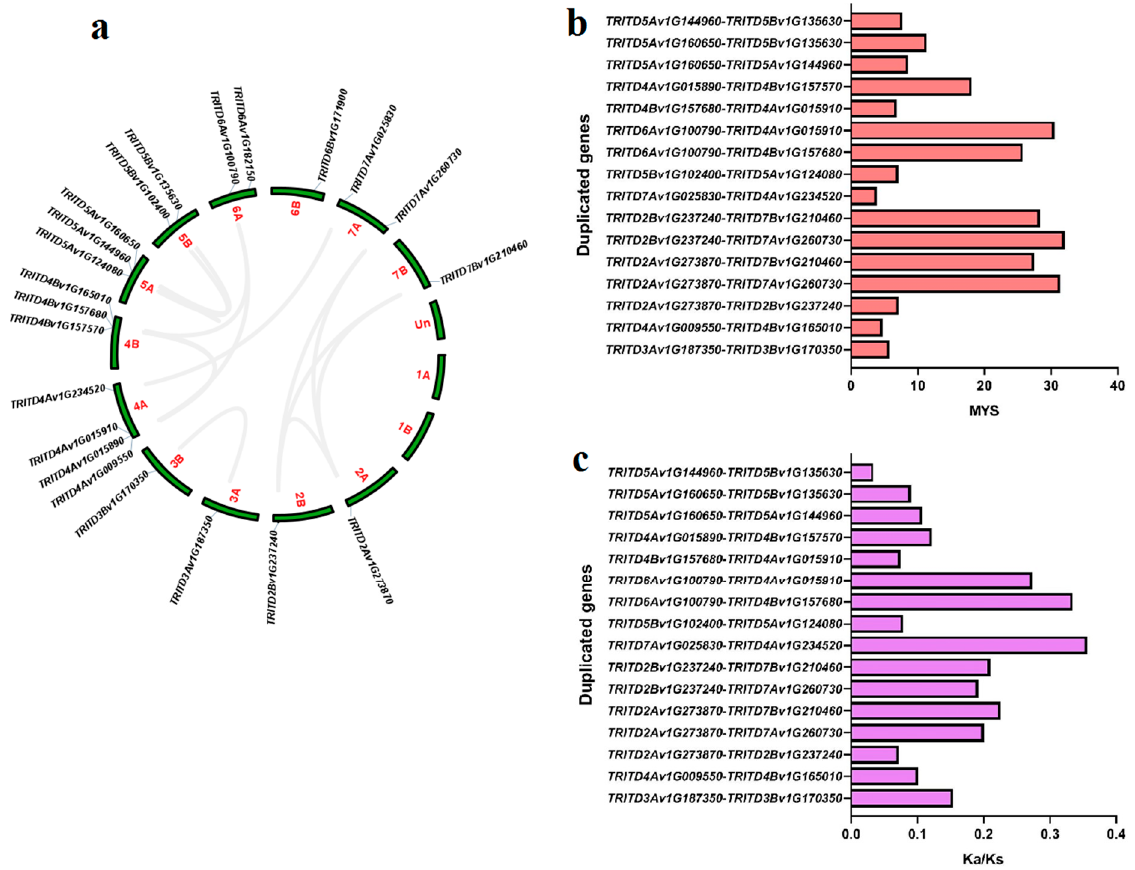
Figure 2. Distribution of TdSULTR genes in the genome of T. turgidum L. ssp. durum (Desf.) , gray lines showed the duplicated genes ( a ), time of divergence of duplicated TdSULTR genes based on million years ago ( b ), and the ratio Ka/Ks of duplicated genes of the Td SULTR gene family ( c ).